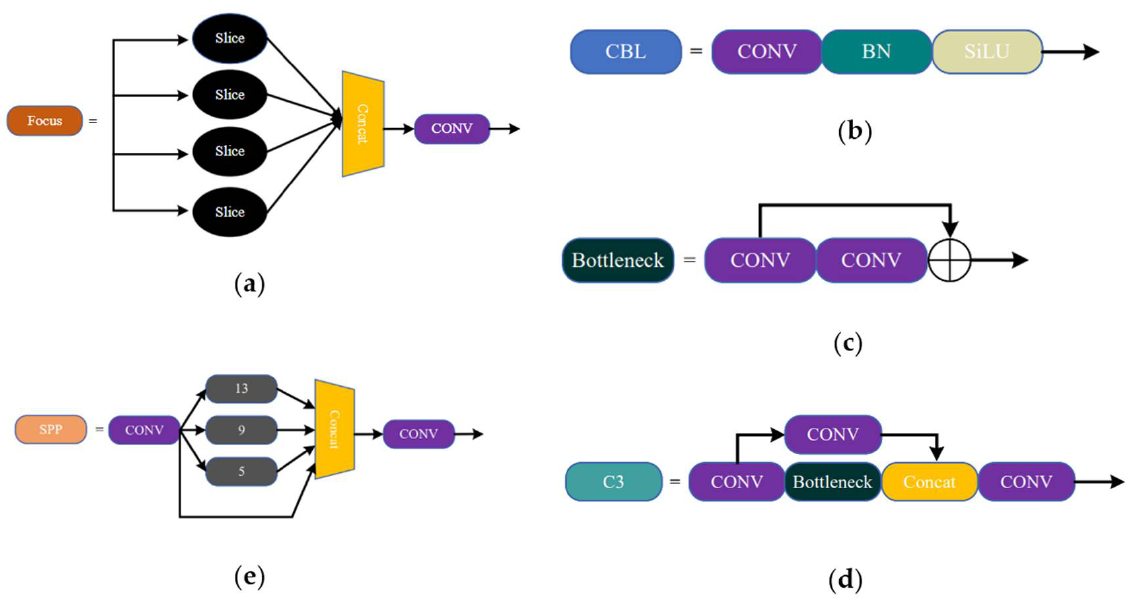
Figure 4. Core components of YOLOv5: ( a ) Focus; ( b ) CBL; ( c ) Bottleneck; ( d ) C3; ( e ) SPP.